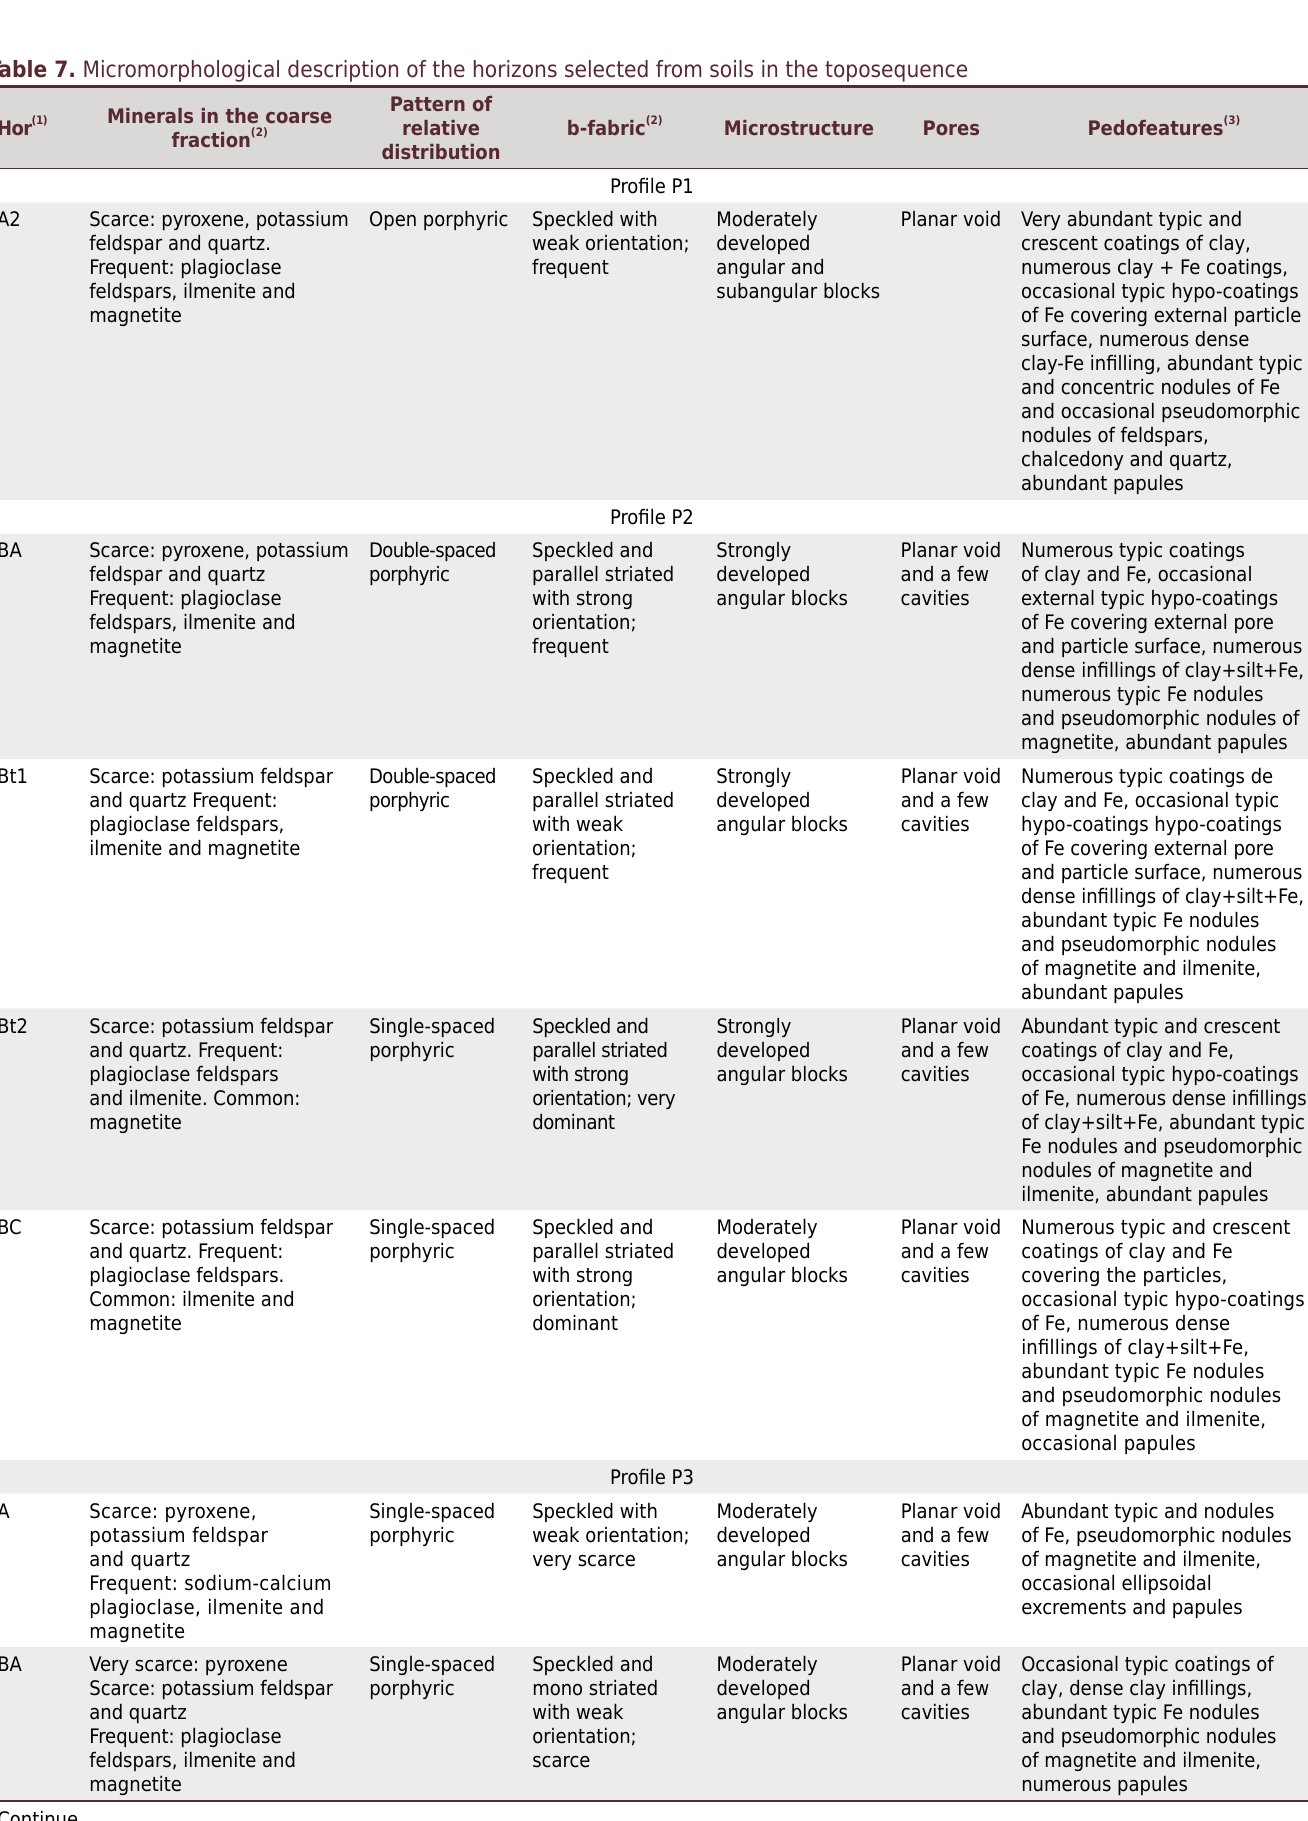
Table 7. Micromorphological description of the horizons selected from soils in the toposequence Hor (1)